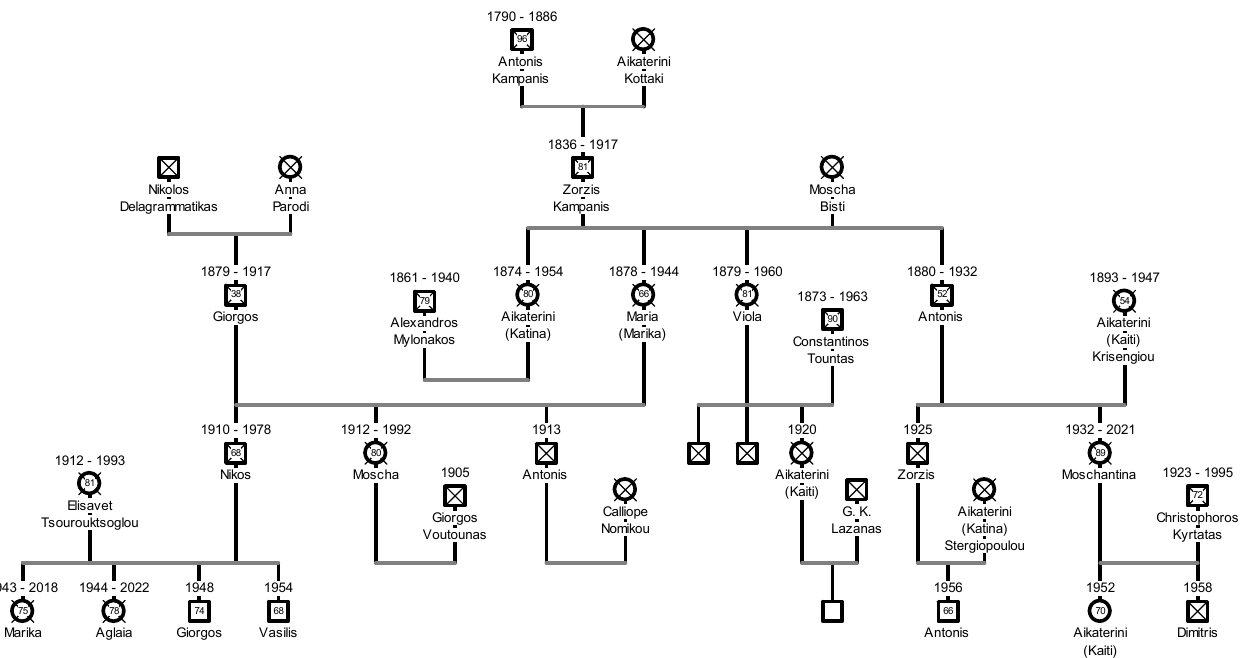
Figure 5. Family tree of Moscha Delagrammatika.